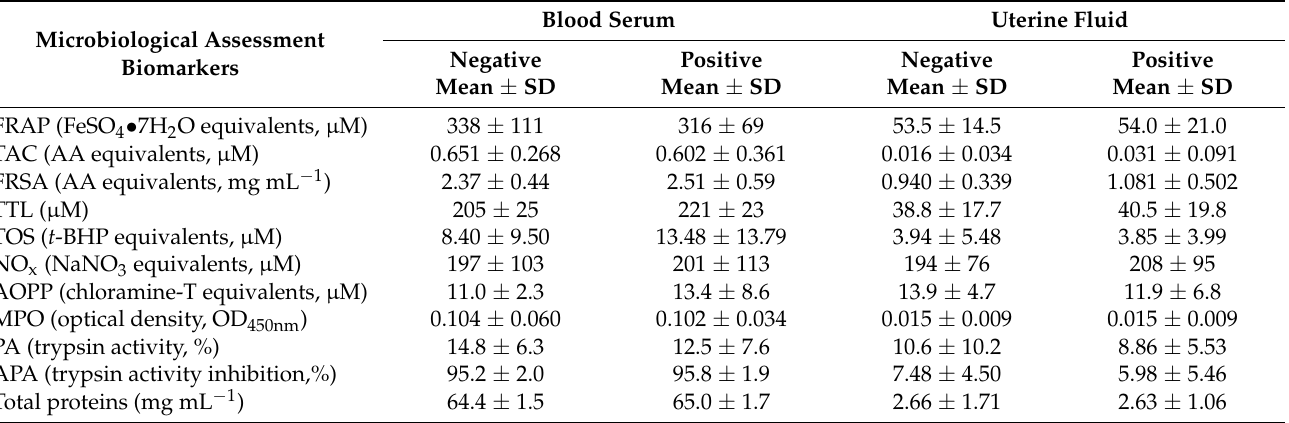
Table 1. Mean (±SD) values of oxidative, inflammation, and protease regulator biomarkers assessed in the blood serum and the uterine fluid of mares with negative (n = 9) and positive (n = 24) outcomes for the diagnosis of endometritis based on microbiological assessment.